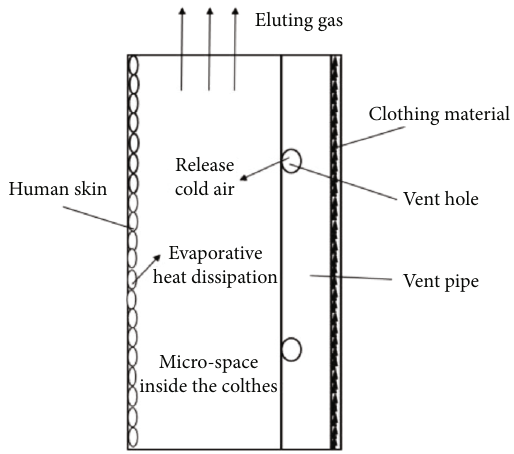
Figure 1: Schematic fi gure of cooling principle of mine ventilation